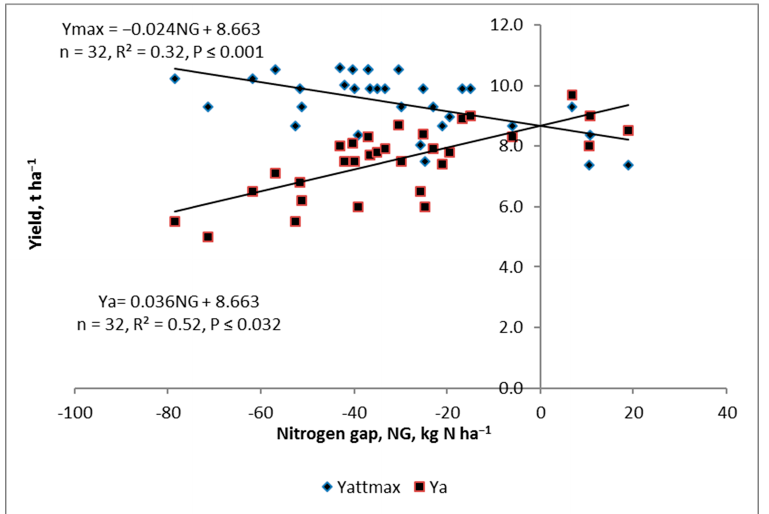
Figure 2. Trends in actual and maximum attainable yields in response to Nitrogen Gap in winter wheat. Legend: NG—nitrogen gap; Y attmax —maximum attainable yield; Y a —actual yield.